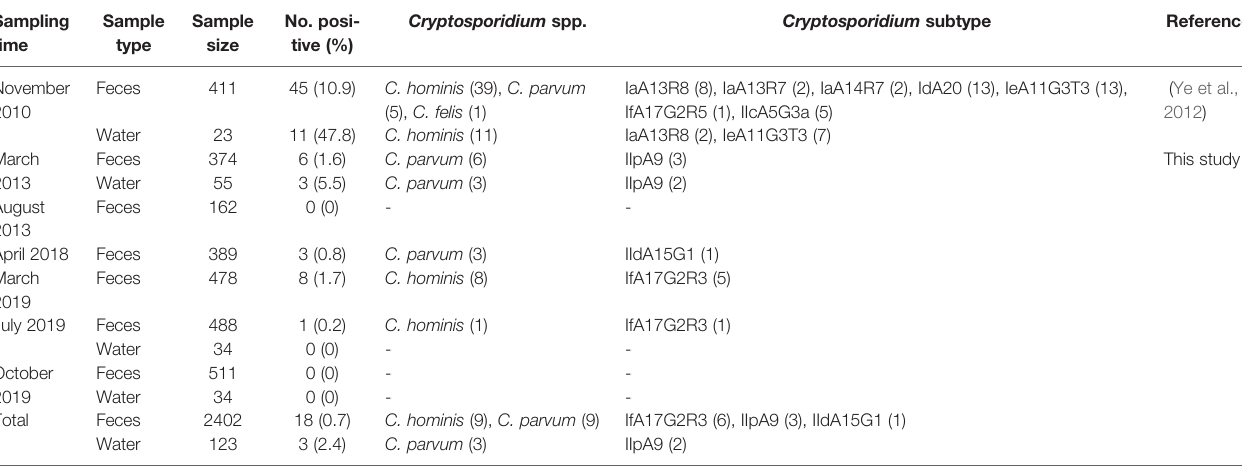
TABLE 1 | Detection rates and distribution of Cryptosporidium species and subtypes in samples from rhesus monkeys and water in Qianling Mountain Park, Guiyang, China. Sampling